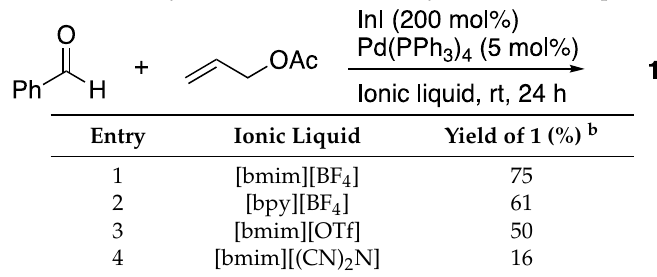
Table 2. Pd ‐ catalyzed indium ‐ mediated allylation in ionic liquid a .